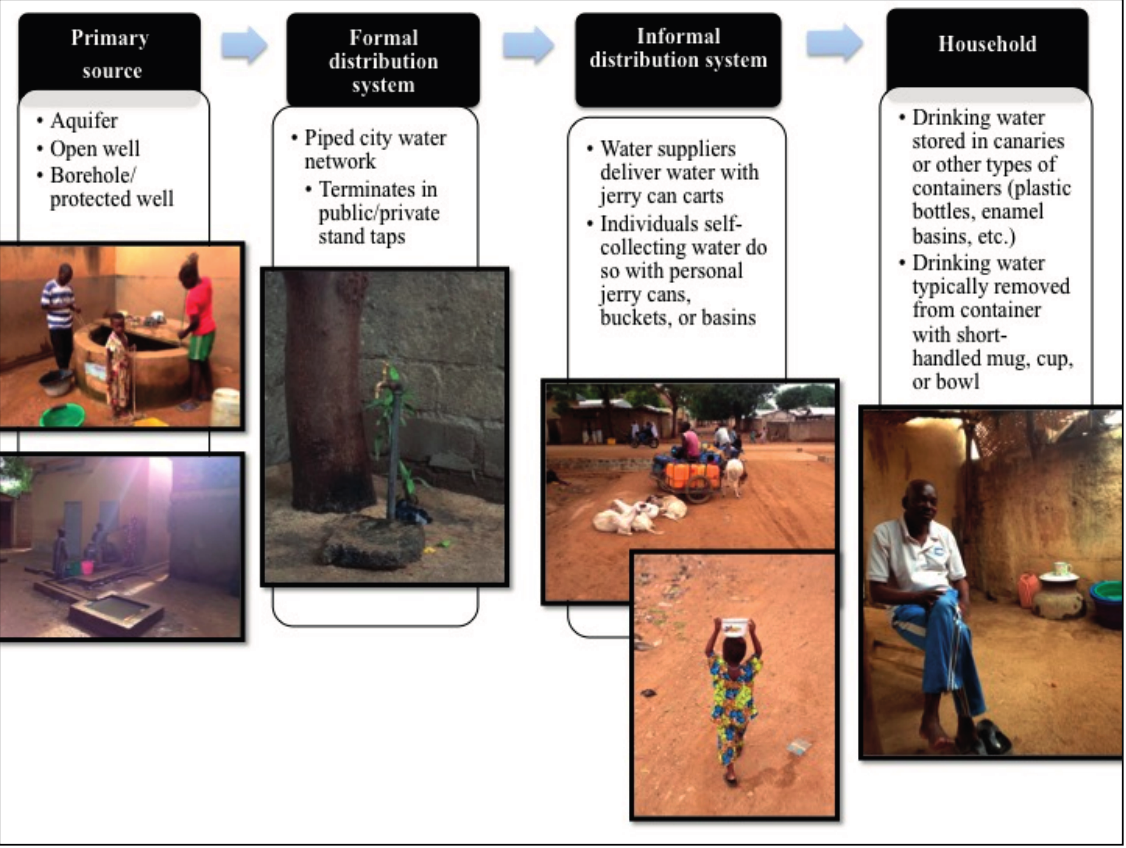
Figure 1. Flowchart of the drinking water delivery chain in Maroua including both formal and informal distribution